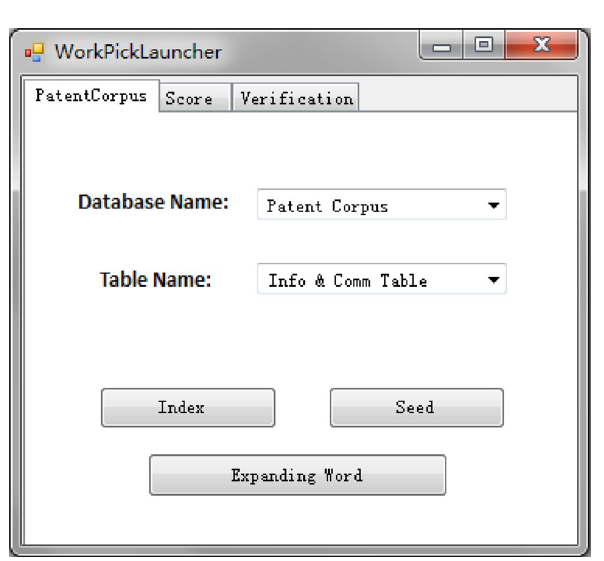
Figure 2. Patent corpus selection